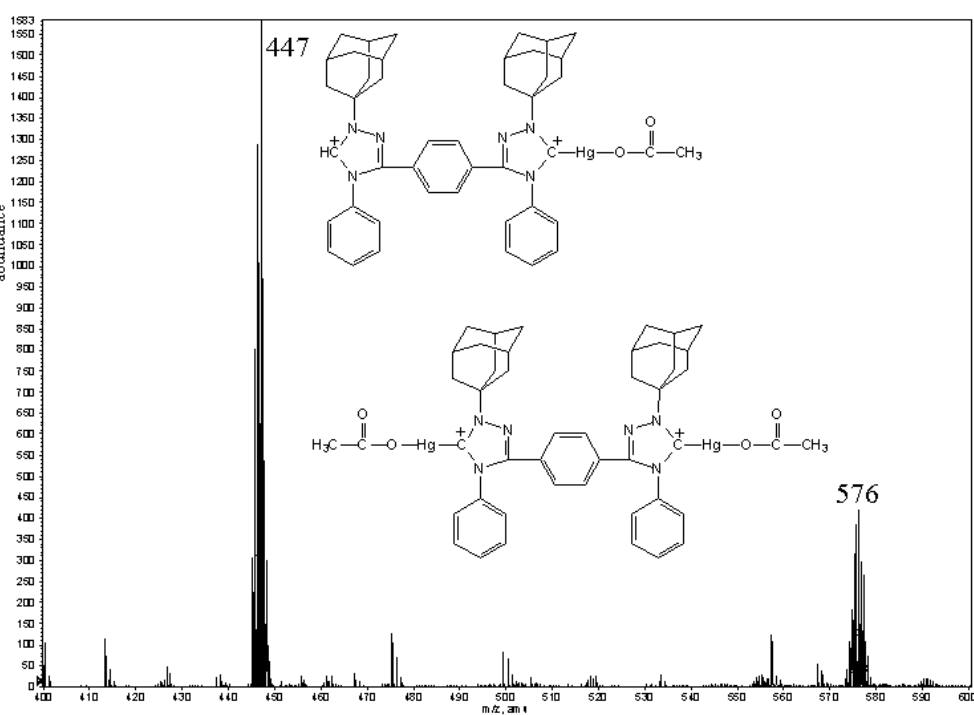
Fig. 2 Full scan mass spectrum obtained for solution containing precursor 5 and mercury